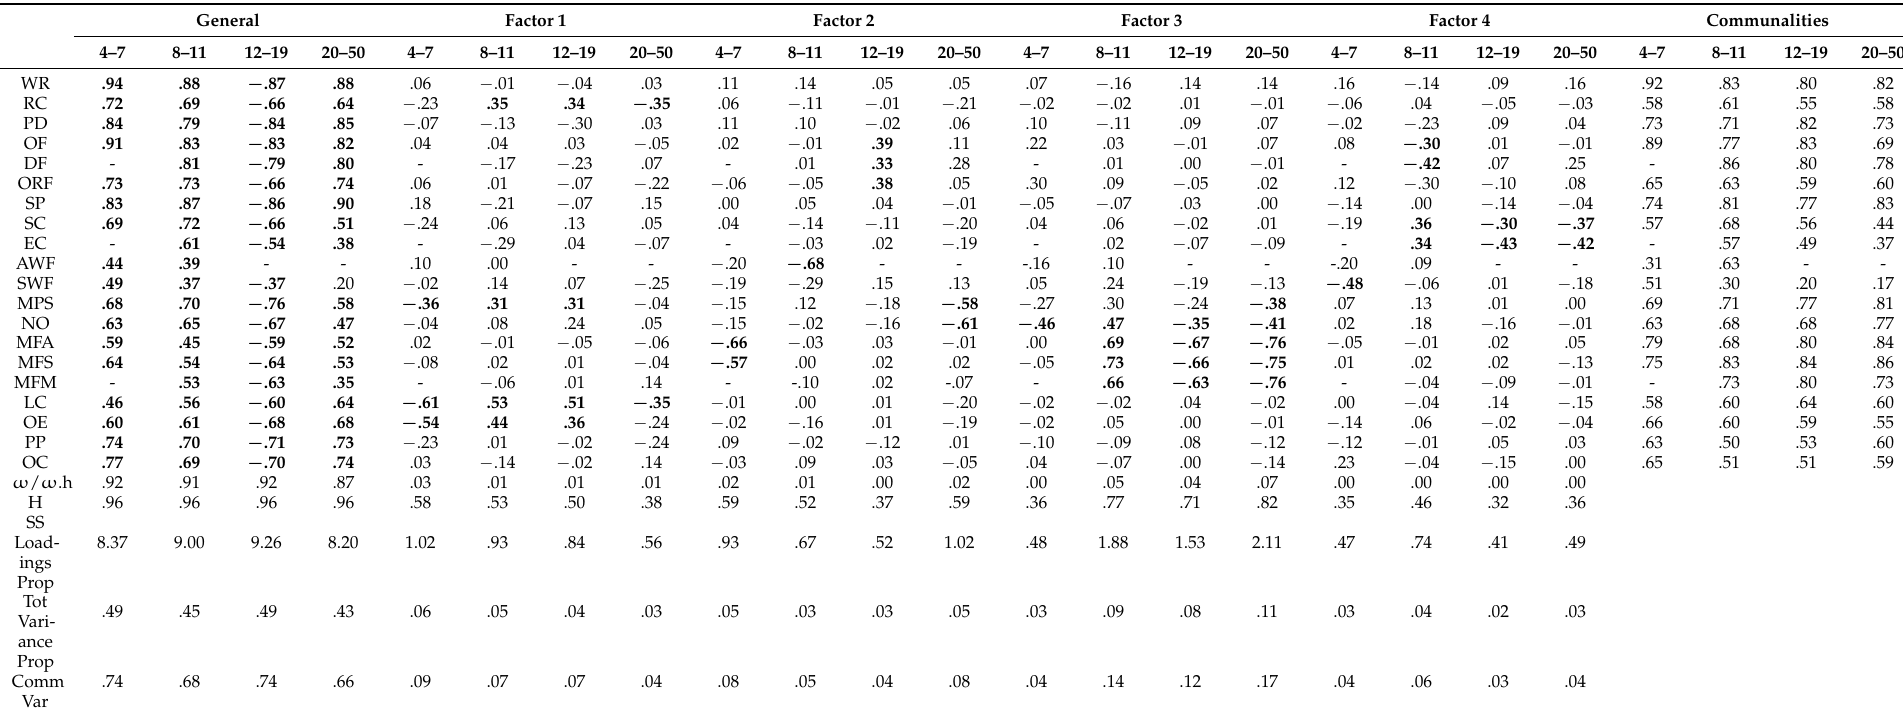
Table A5. Bifactor Solution with Four Specific Factors Across Age